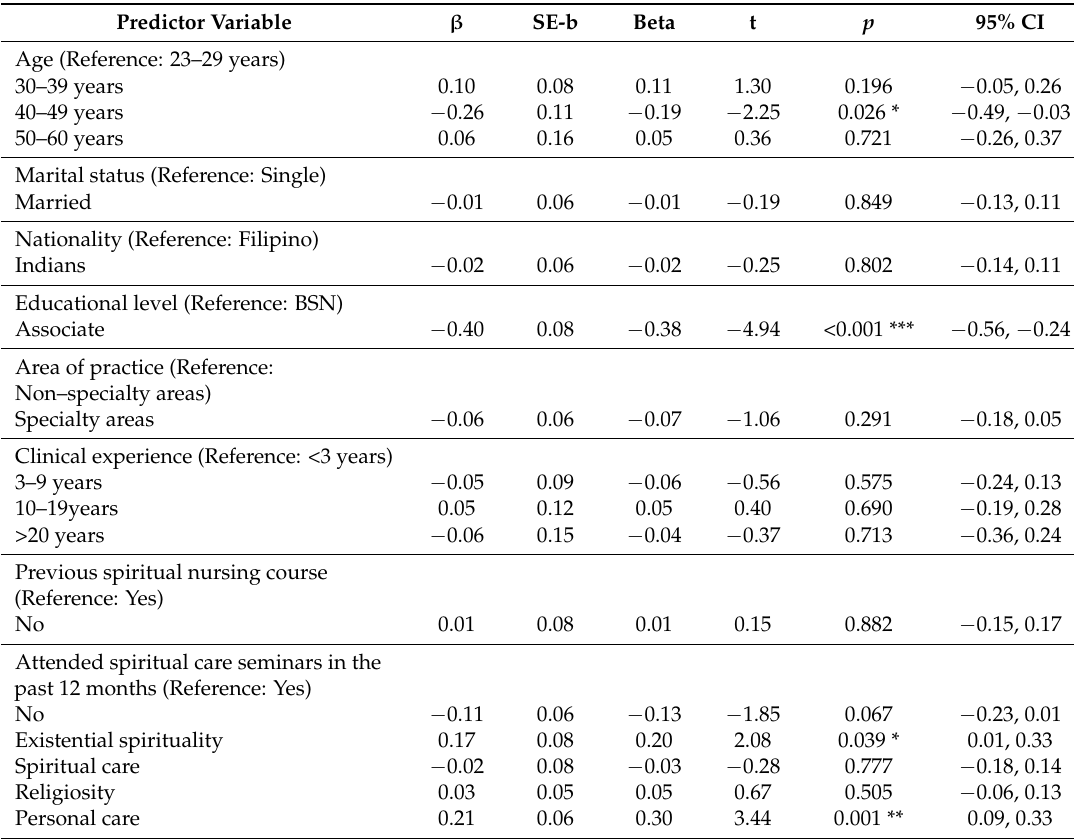
Table 4. Predictors of spiritual care competence ( n =